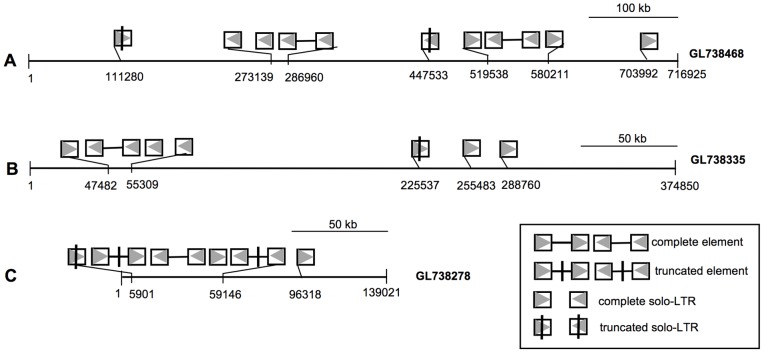
Uneven distribution of PbTRIM elements and their solo-LTRs in the P. barbatus genome.PbTRIM elements and solo-LTRs tend to form closely located clusters in some genomic regions.